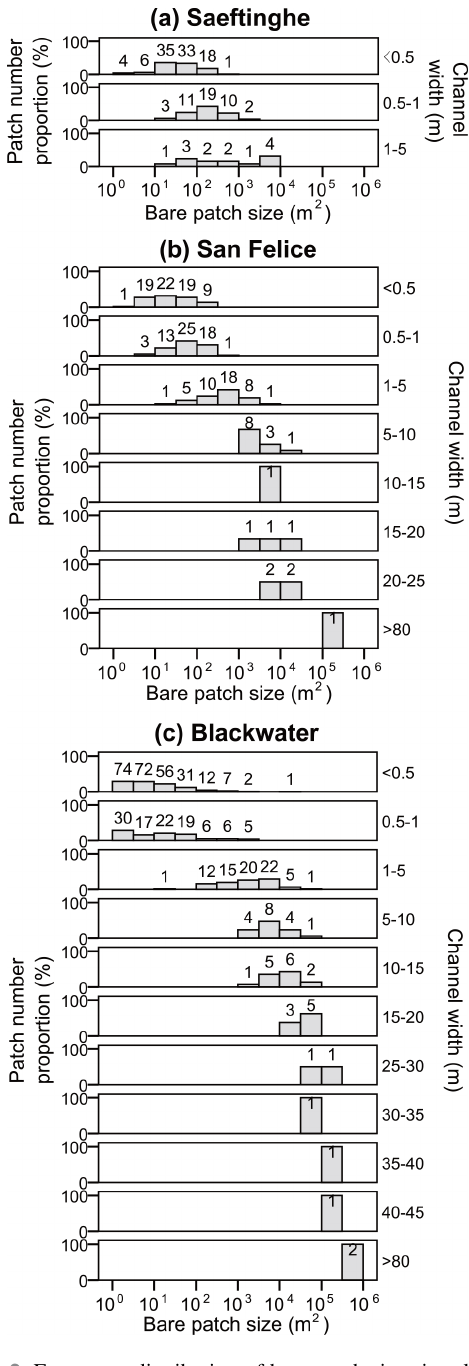
Figure 6. Frequency distribution of bare patch sizes in relation to the connected channel width in (a) Saeftinghe, (b) San Felice, and (c) Blackwater. Note the x axis is in logarithmic scale. Bare patches with connecting channel widths < 0.5m are defined as unconnected bare patches in the text (see Sect. 3.1). The patch number propor- tion (%) is calculated as the number of bare patches in each class of bare patch size relative to the total number of bare patches for each category of channel width. The number of bare patches in each size class is labeled at the top of the